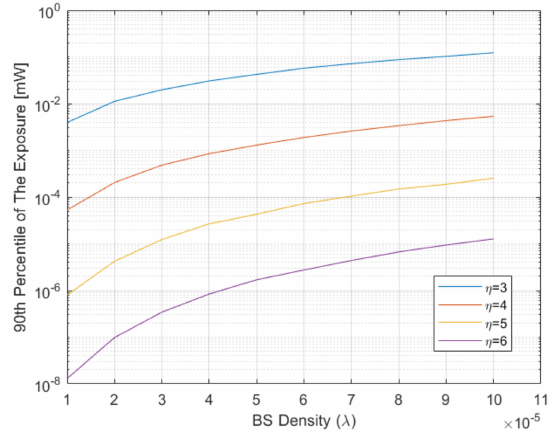
Figure 6. 90th percentile of the exposure as function of BS Density for di ff erent values of the path loss